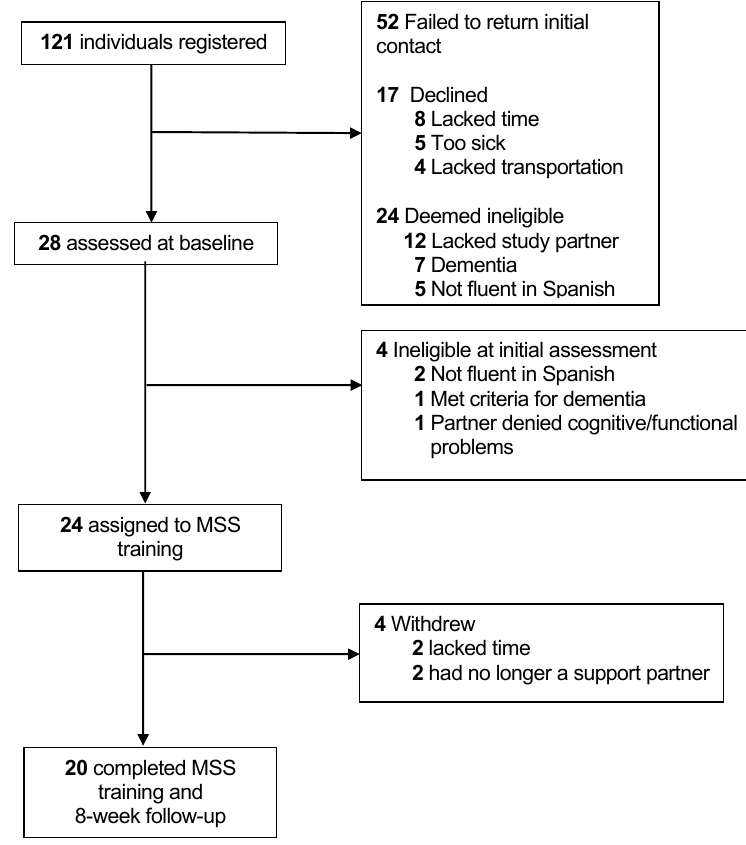
Figure 1. Study recruitment and retention.